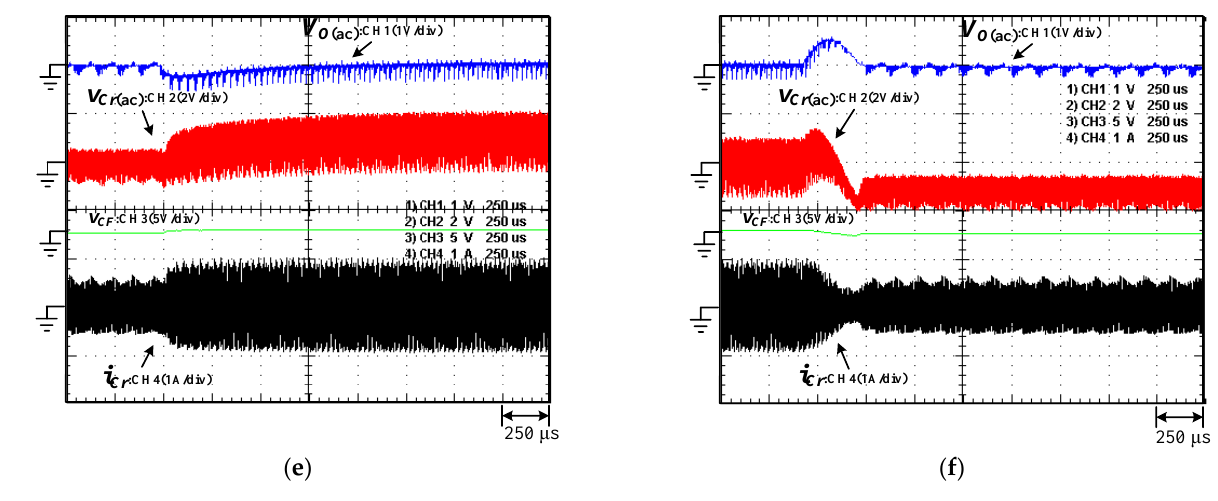
Figure 16. Measured transient waveforms of V o ripple, v Cr ripple, v CF , and i Cr : ( a ) from 50% to 100% load at 24 V input; ( b ) from 100% to 50% load at 24 V input; ( c ) from 50% to 100% load at 36 V input; ( d ) from 100% to 50% load at 36 V input; ( e ) from 50 to 100% load at 48 V input; and ( f ) From 100% to 50% load at 48 V input. Table 3. Measured results of phase margin and gain margin.